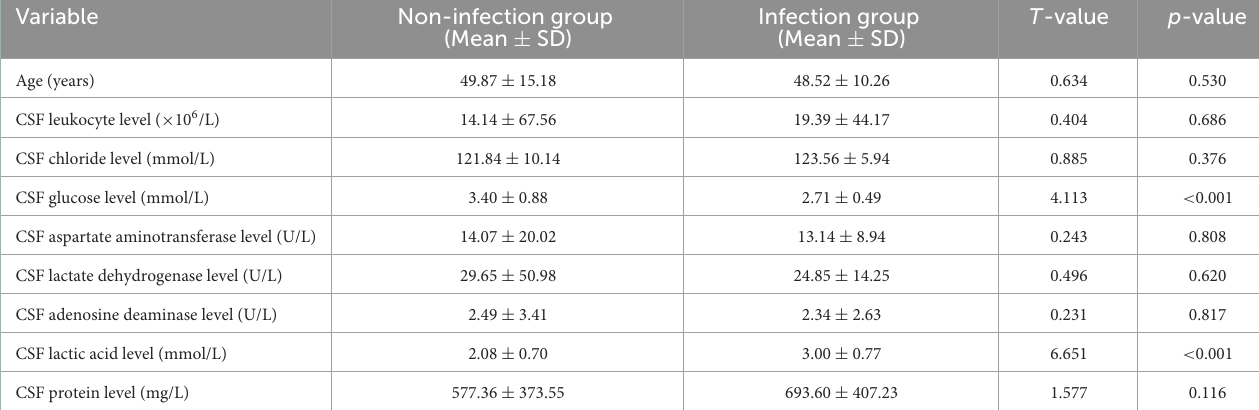
TABLE 3 Single factor analysis of the difference between the two groups in age and CSF parameters.